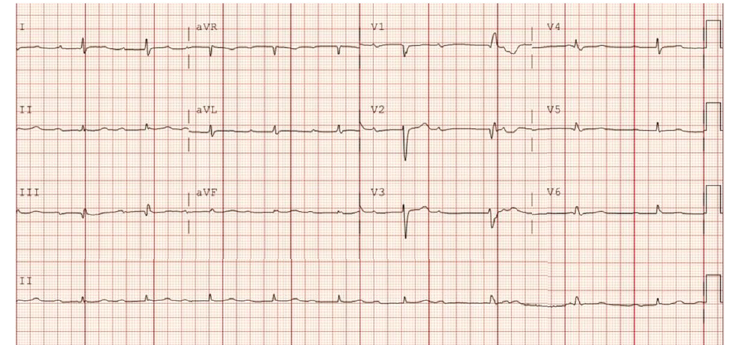
Figure 7: EKG showing Mobitz type 1 AV block.